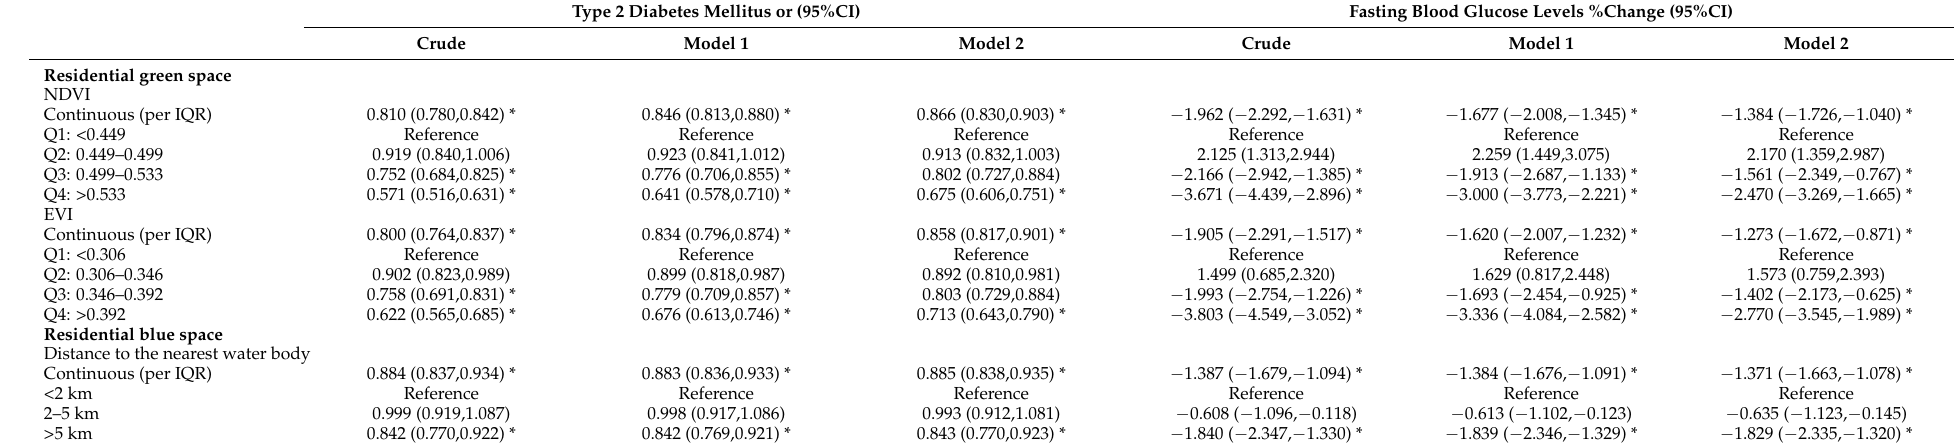
Table 2. Results of regression models for associations between residential environment and type 2 diabetes mellitus and fasting blood glucose